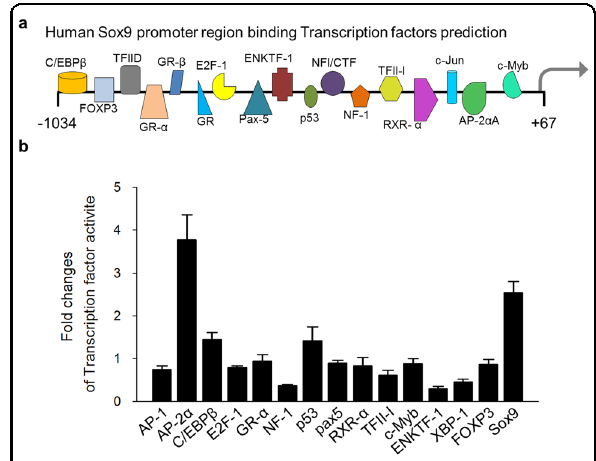
Fig. 4 Transcription factors associated with ELPC in the Sox9 promoter region. a Transcription factors binding to the Sox9 promoter were predicted by the PROMO 3.0 program. b Transcription factor activity, predicted to bind a Sox9 promoter region, was measured using a TF activation plate array kit (customizing kit,